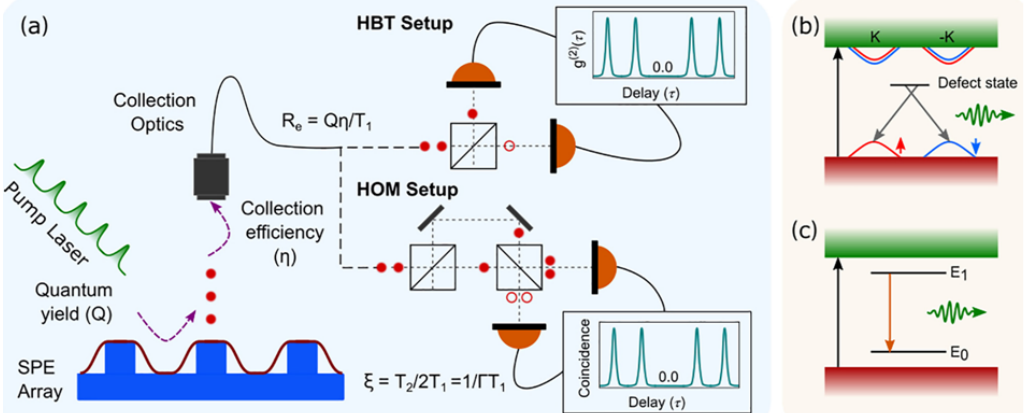
Figure 13. Single-photon emission and characterization of 2D materials. ( a ) An illustration of the characterization of the single photons generated from an array of SPEs. The system is excited with a pulsed pump laser at a repetition rate of T e . The quantum emitter responds by emitting a photon with a probability of Q (quantum yield) per pulse. This photon will be collected by the measurement apparatus with a collection efficiency of g, setting the effective brightness of the system at Q. η /T e . Note that maximum repetition rate can be limited by the lifetime ( T 1 ) of the emitter. The Hanbury Brown and Twiss (HBT) setup is used to measure the purity [g 2 (0)] of the generated photons. ( b ) Schematic of single-photon generation from localized excitons in TMDs (e.g., WSe 2 ). The strain-localized excitons hybridize with point defects, leading to valley selectivity breaking and strong photoemission. ( c ) Single-photon generation from deep defect levels ( E 0 and E 1 ) in wide bandgap insulators (e.g., hBN) [66].